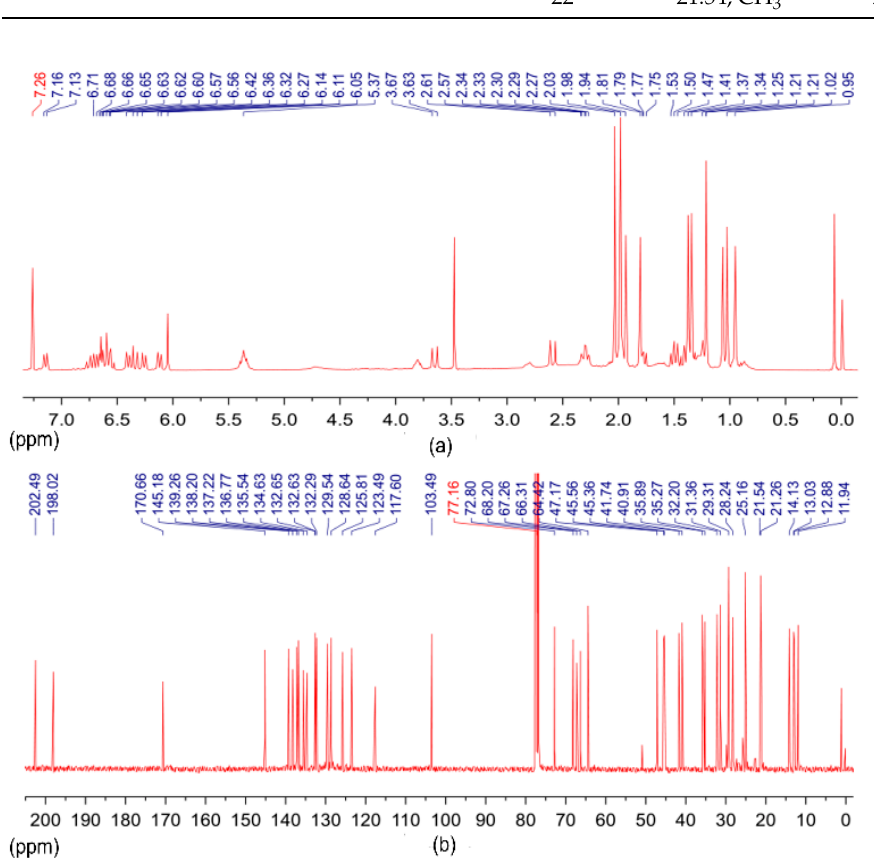
Figure 6. NMR spectra of the purified compounds: ( a ) 1 H NMR spectrum; ( b ) 13 C NMR spectrum.